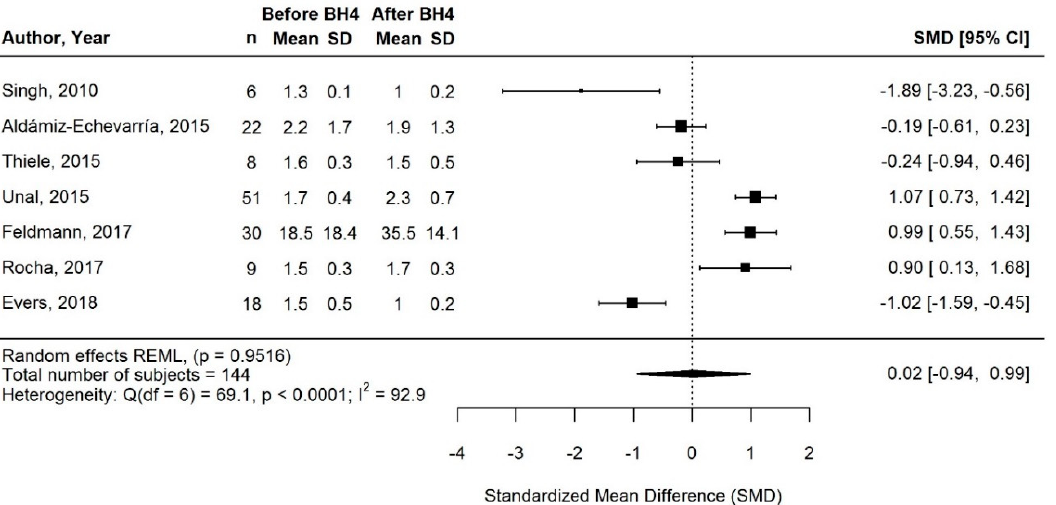
Figure 4. Standardized change in protein equivalent intake from protein substitute of long-term responders on BH4 treatment. Means and SDs before/after BH4 are gram protein equivalent per day for Lambruschini (2005) and Singh (2011), and gram per kilogram bodyweight per day for all other studies. Abbreviations: BH4, tetrahydrobiopterin; CI: confidence interval; n: sample size; SD: standard deviation; SMD, standardized mean difference.